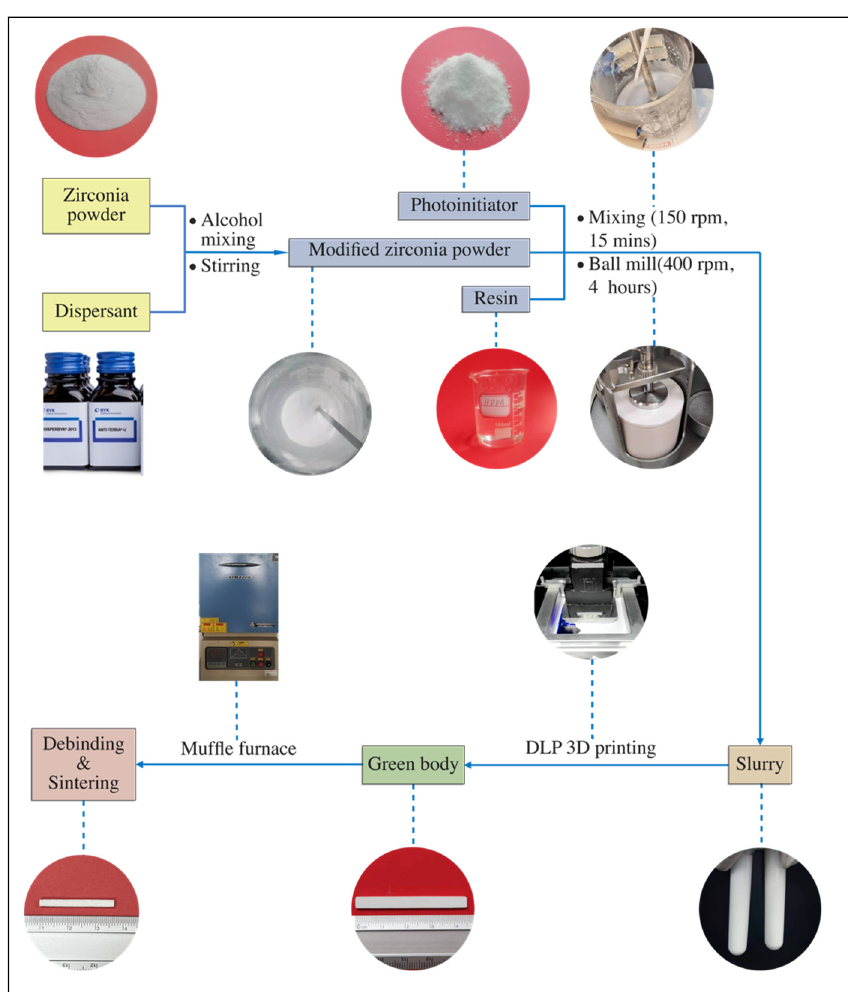
Figure 1. The fabrication process of DLP 3D printing ZrO 2